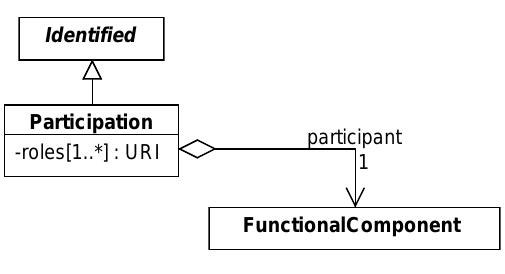
Figure 18: Diagram of the Participation class and its associated properties.